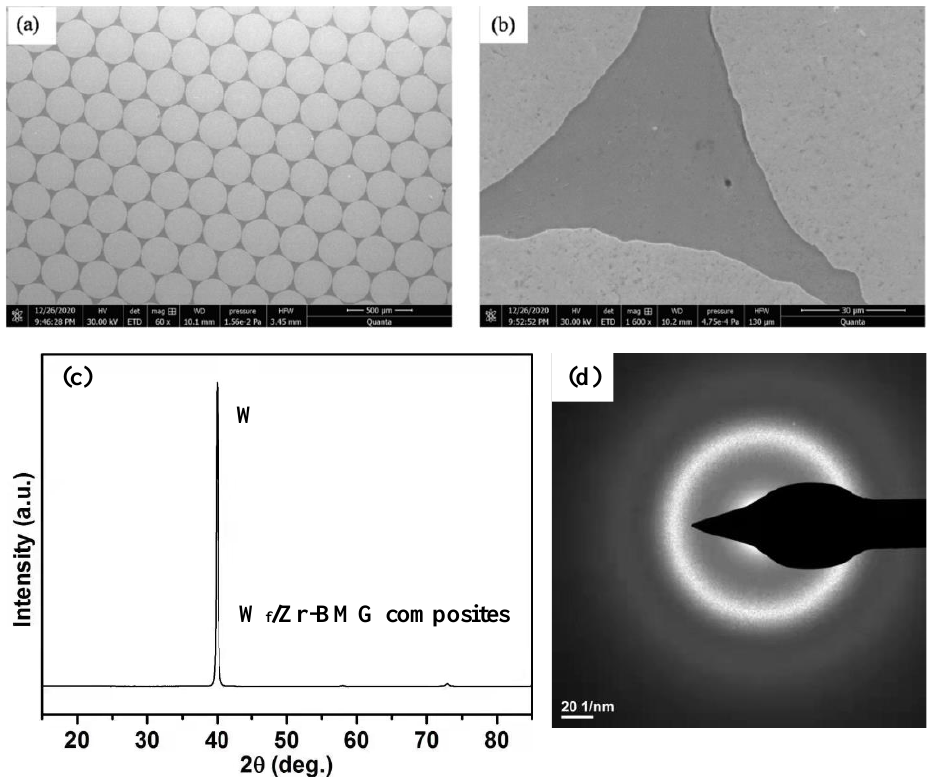
Figure 3. The microstructure characteristic of the Wf/Zr-based BMG composite, SEM micrograph in the back scatter mode of 80 vol.% Wf/Zr-MG composite ( a ); local zoom ( b ) (the light-colored section represents the tungsten fiber; the dark-colored part represents the Zr-based bulk metallic glass); X-ray of the composite ( c ); and TEM electron diffraction pattern of Zr-MG ( d ).